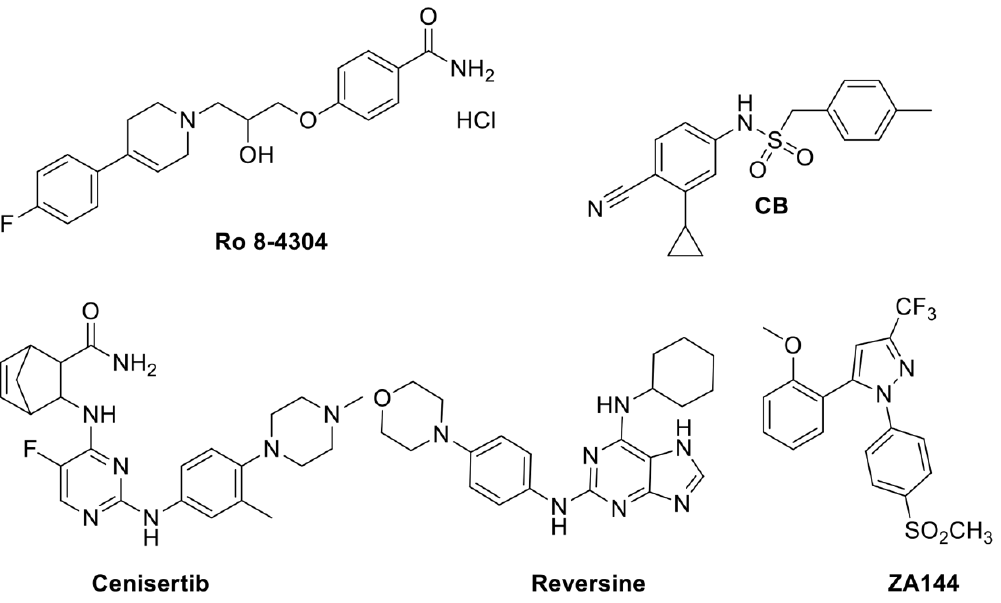
Figure 4. Chemical structures of small molecules involved in plant response to biotic and abiotic stress. Biotic stress: Ro 8-4304 [68], Reversine and cenisertib [69]. Abiotic stress: CB [92], ZA144 [98].